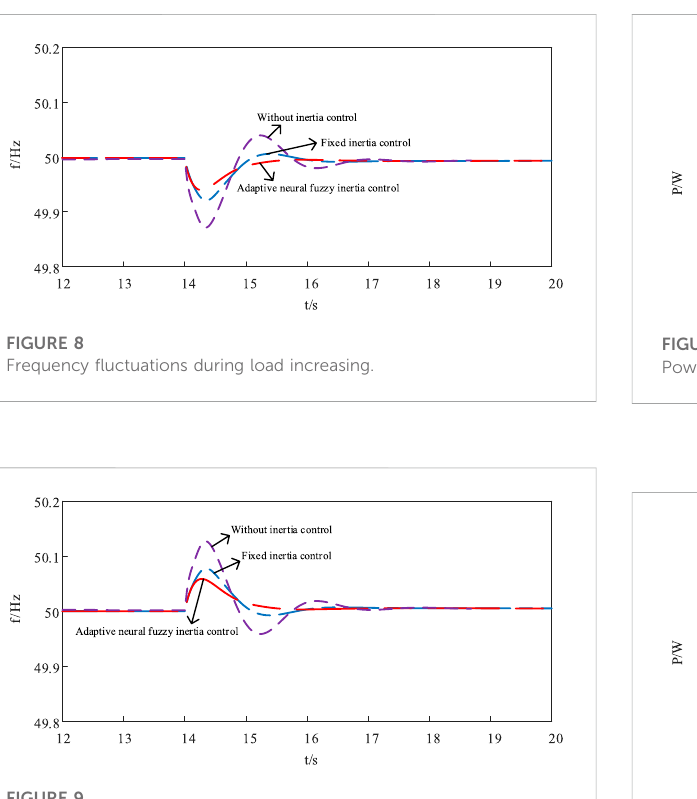
FIGURE 9 Frequency fl uctuations during load decreasing.